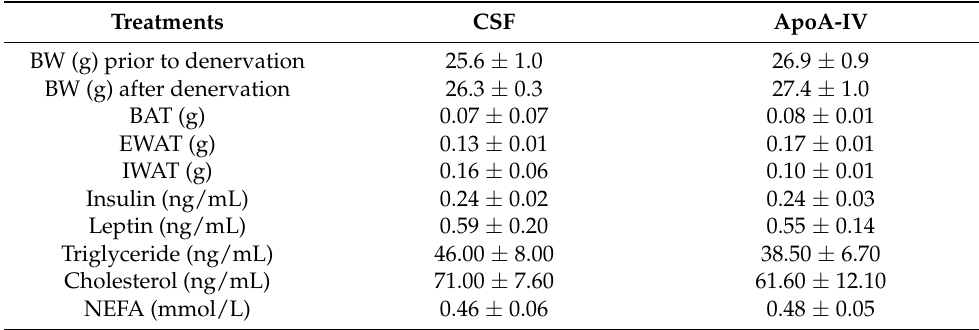
Table 2. Experiment 2: Body weight, tissue weights, and levels of plasma parameters. After fasting for five hours, mice (n = 7/group) received intracerebral administration of either CSF (1 µL) or re- combinant ApoA-IV protein at 12 µg/µL (1 µL). Plasma and tissues were collected 40 min after injections. Values are presented as the means ± SEM. BW: body weight; BAT: brown adipose tis- sue; EWAT: epididymal white adipose tissue; IWAT: inguinal white adipose tissue.